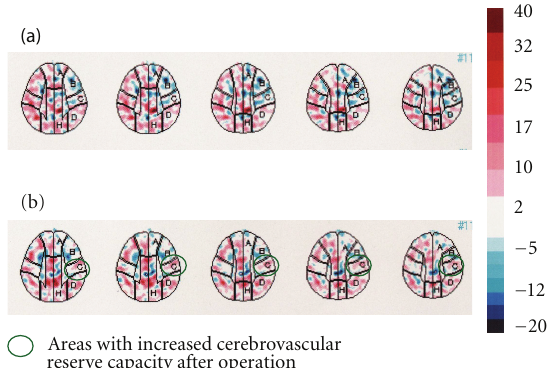
Figure 4: Evaluation of the increase rate of cerebral blood flow (CBF) under diamox stress using a three-dimensional stereotactic region of interest template analysis of 99m Technetium-ethyl-cysteinate-dimer CBF single-photon emission computed tomography (preoperative (a); postoperative (b)). Preoperative CBF increase rate under diamox stress was impaired more around the central sulcus than on the ipsilateral side (2.2% and 10.8%, resp.). Postoperative CBF increase rate by acetazolamide stress around the left central sulcus was improved (5.7%, green circle) compared with that observed during the preoperative study.